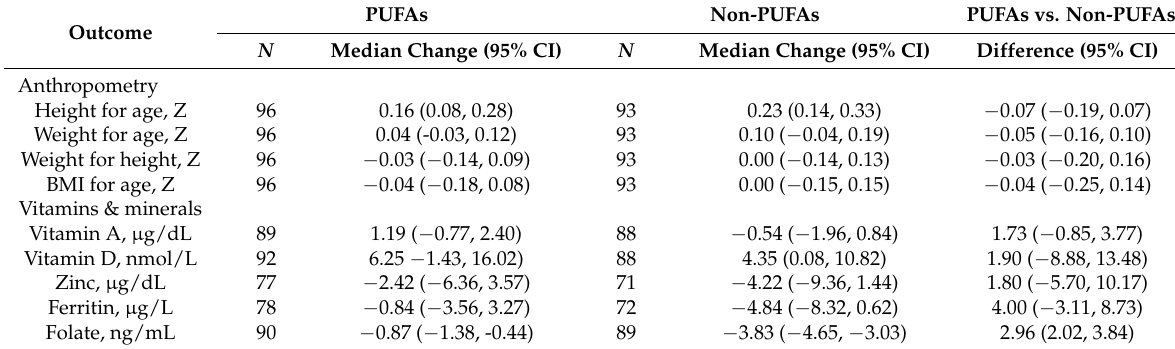
Table 4. Covariate-adjusted median changes a of anthropometric and micronutrient outcomes between baseline and after four months, by treatment